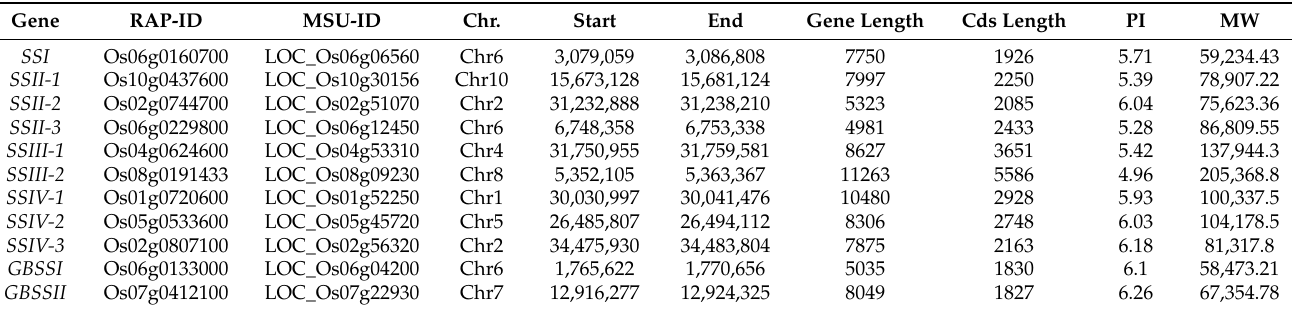
Table 1. Gene list and information for starch synthase.